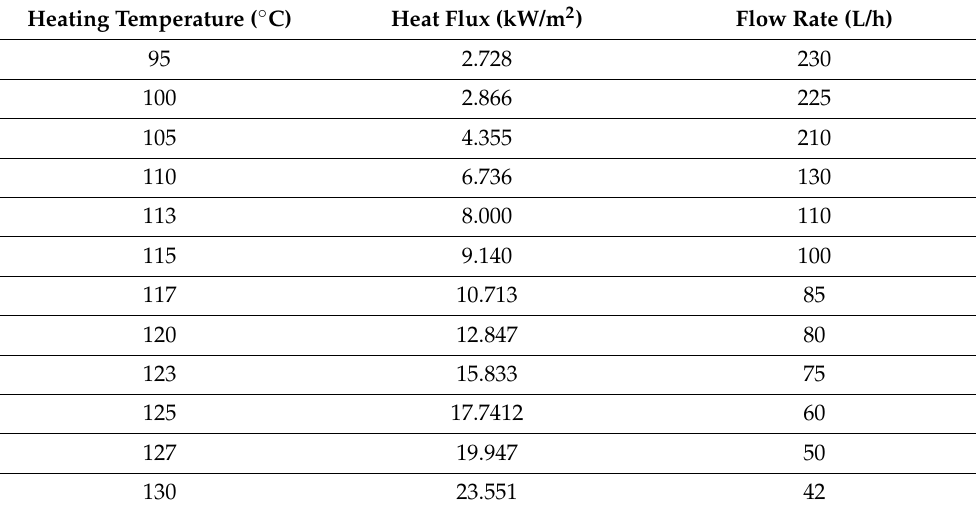
Table 1. The heating condition and flow rate of the experiments.